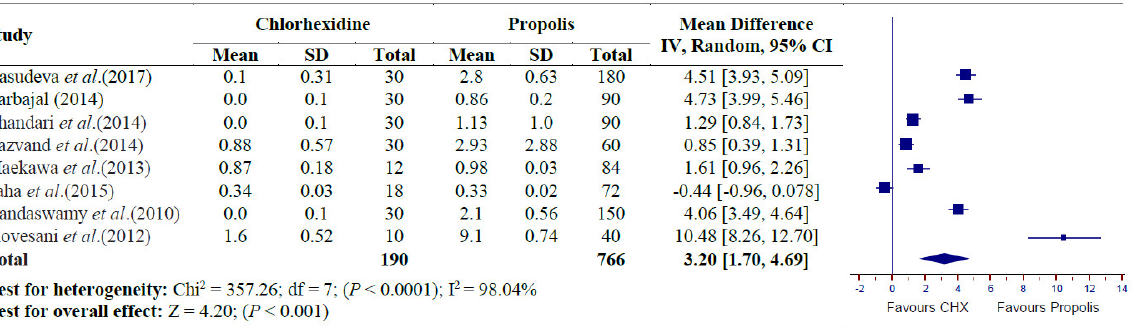
Figure 2. Forest plot showing standard mean difference between Propolis and CHX (control group) treatment in the reduction of E. Faecalis Colony forming units.